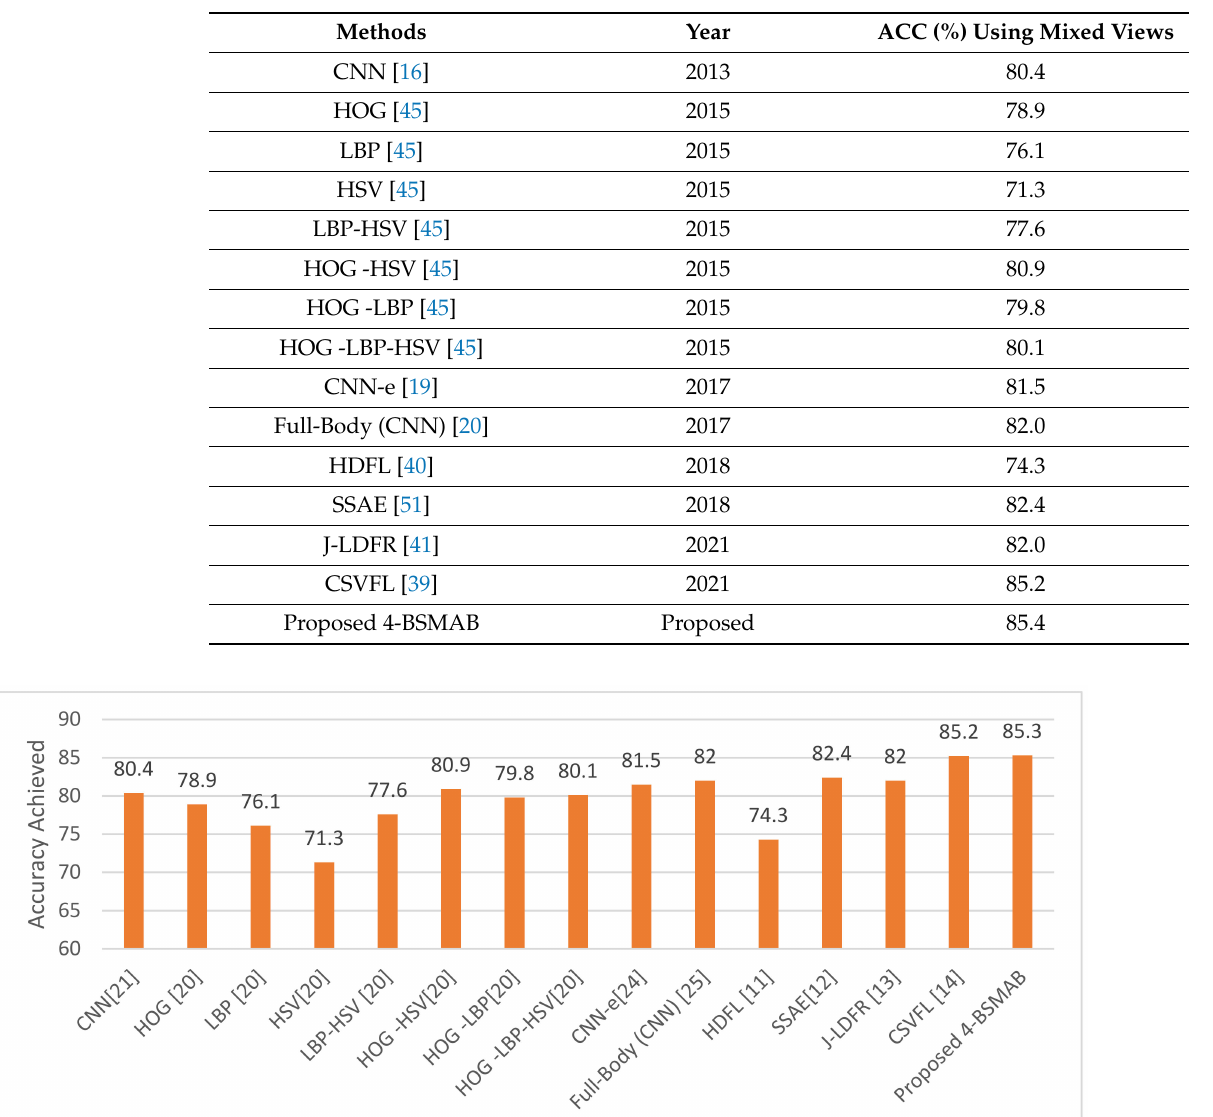
Table 15. Performance comparison of results of proposed and existing PGC methods on MIT dataset.